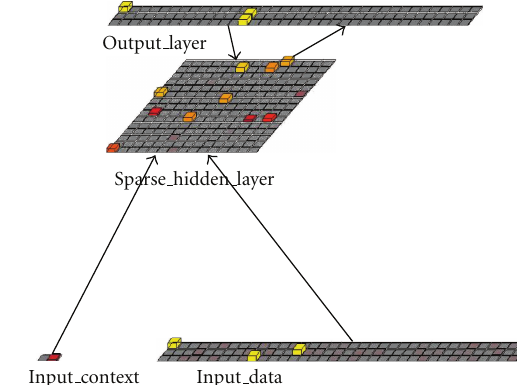
Figure 6: The Leabra network for robot manipulator